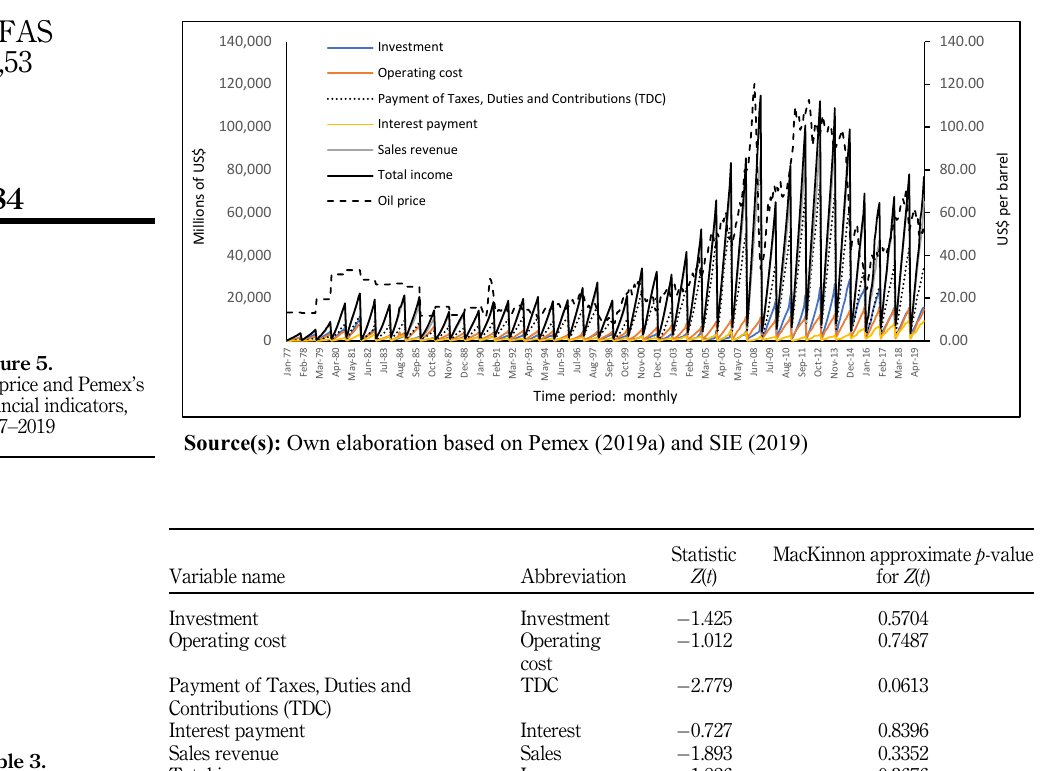
Table 3. Results of